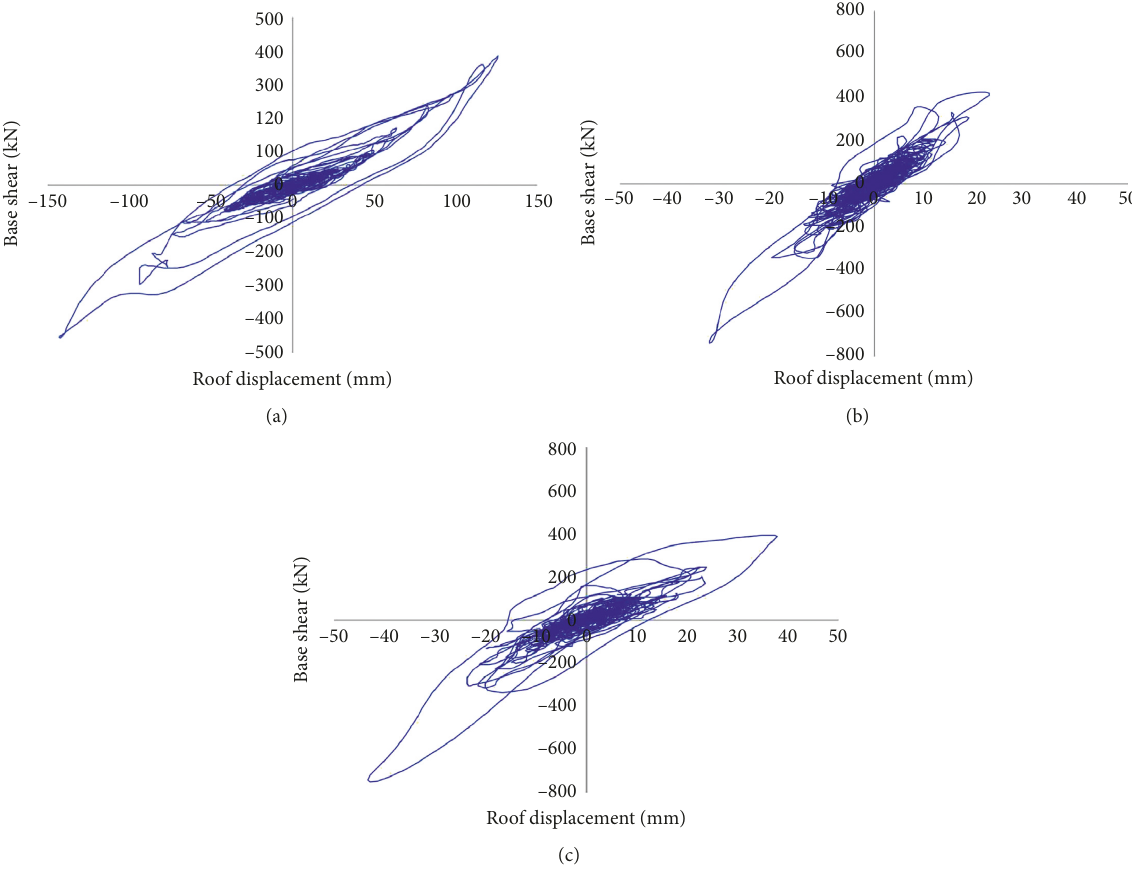
Figure 14: Measured force-displacement hysteretic response of the prototype of test models for NR2. (a) Bare frame. (b) Hybrid masonry- infilled. (c) Masonry-infilled.